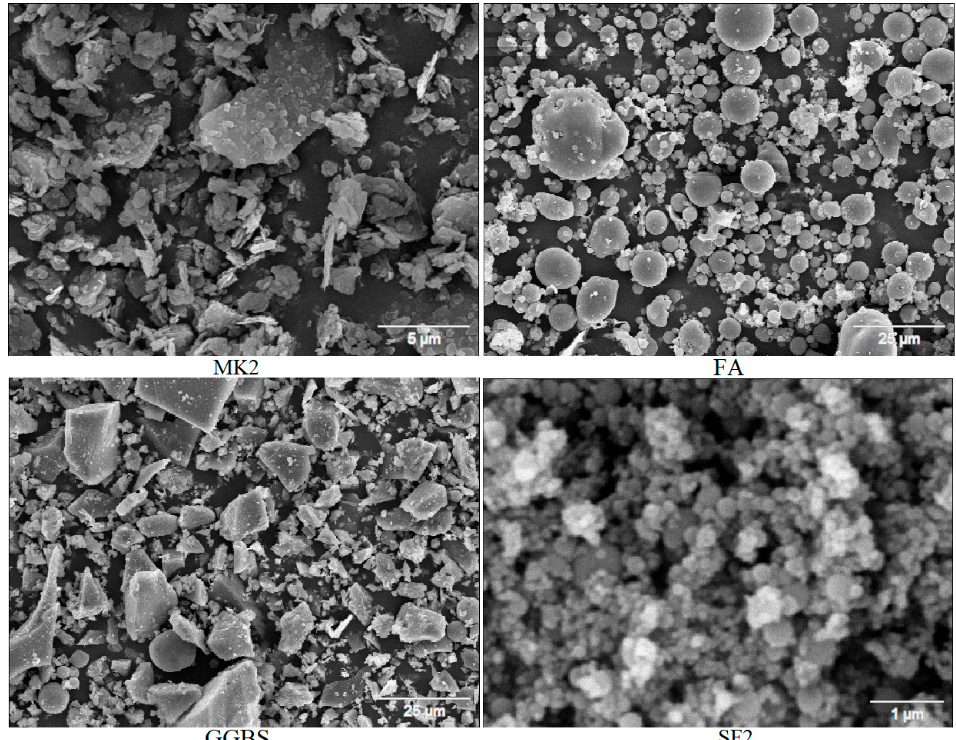
Figure 2. SEM image of source materials.